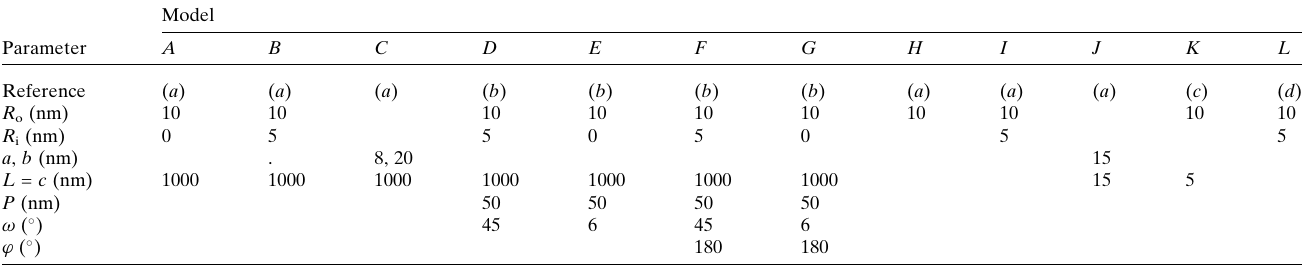
Table 2 Detailed dimensions of the models shown in Figs. 3 and 4; explanations of the model variables can be found in the corresponding references.